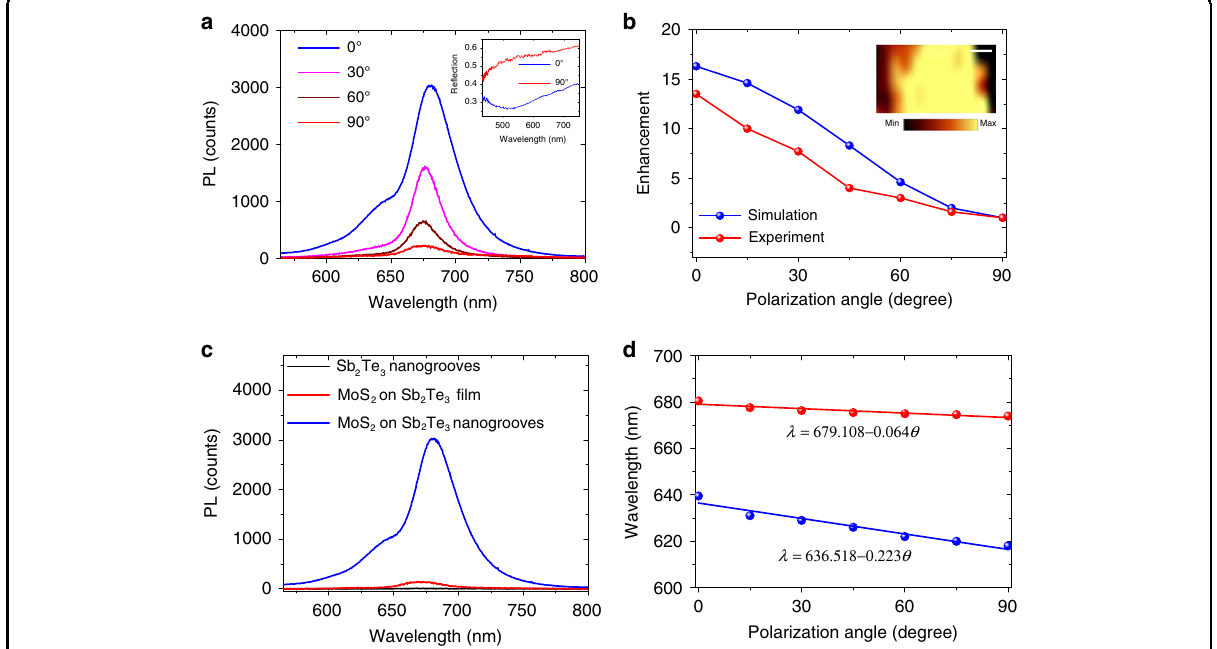
Fig. 5 PL emission response of the monolayer MoS 2 /Sb 2 Te 3 nanogroove heterostructure. a PL emission spectra of the monolayer MoS 2 /Sb 2 Te 3 nanogroove heterostructure for different incident polarization angles θ . The inset shows the re fl ection spectra of Sb 2 Te 3 nanogrooves with monolayer MoS 2 when θ = 0° and 90°. b Enhancement factors of the integrated electric fi eld intensity in Sb 2 Te 3 nanogrooves at 532 nm and PL emission at the A excitonic peak of monolayer MoS 2 for different θ compared to the case of θ = 90°. The inset shows the PL intensity map spectrally integrated in the range of 665 – 695 nm when θ = 0° in the nanogroove area marked as the white dashed square frame in Fig. 4a. The scale bar is 1 μ m. c PL emission spectra from the Sb 2 Te 3 nanogrooves and monolayer MoS 2 on the Sb 2 Te 3 fi lm/nanogrooves. d Dependence of A and B excitonic peak wavelengths on θ